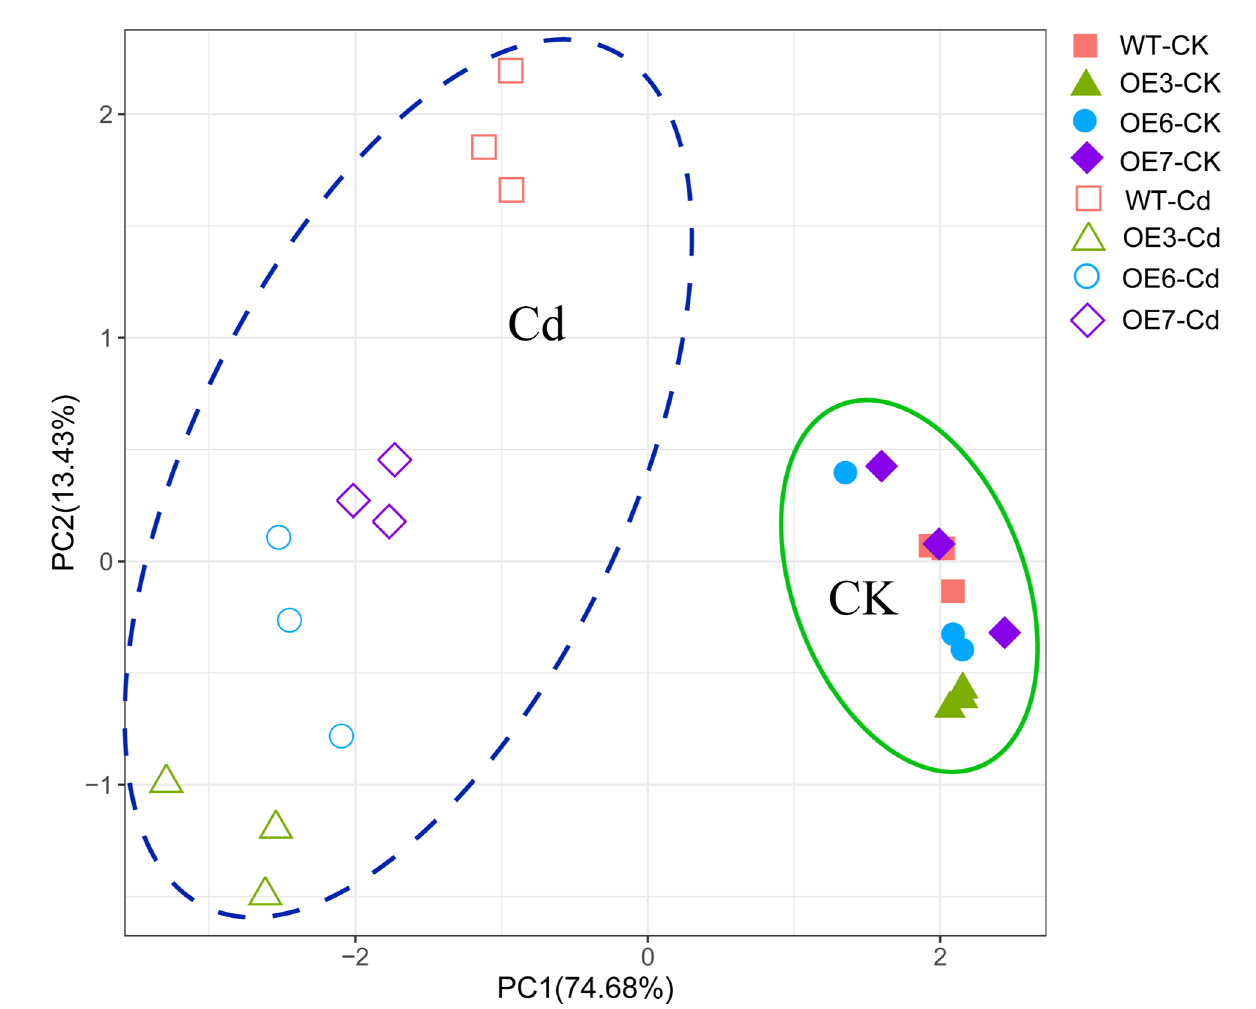
FIGURE 9 Principal component analysis plots of the Cd concentrations and ROS, antioxidant, and titratable acid contents in the roots and leaves of WT and transgenic